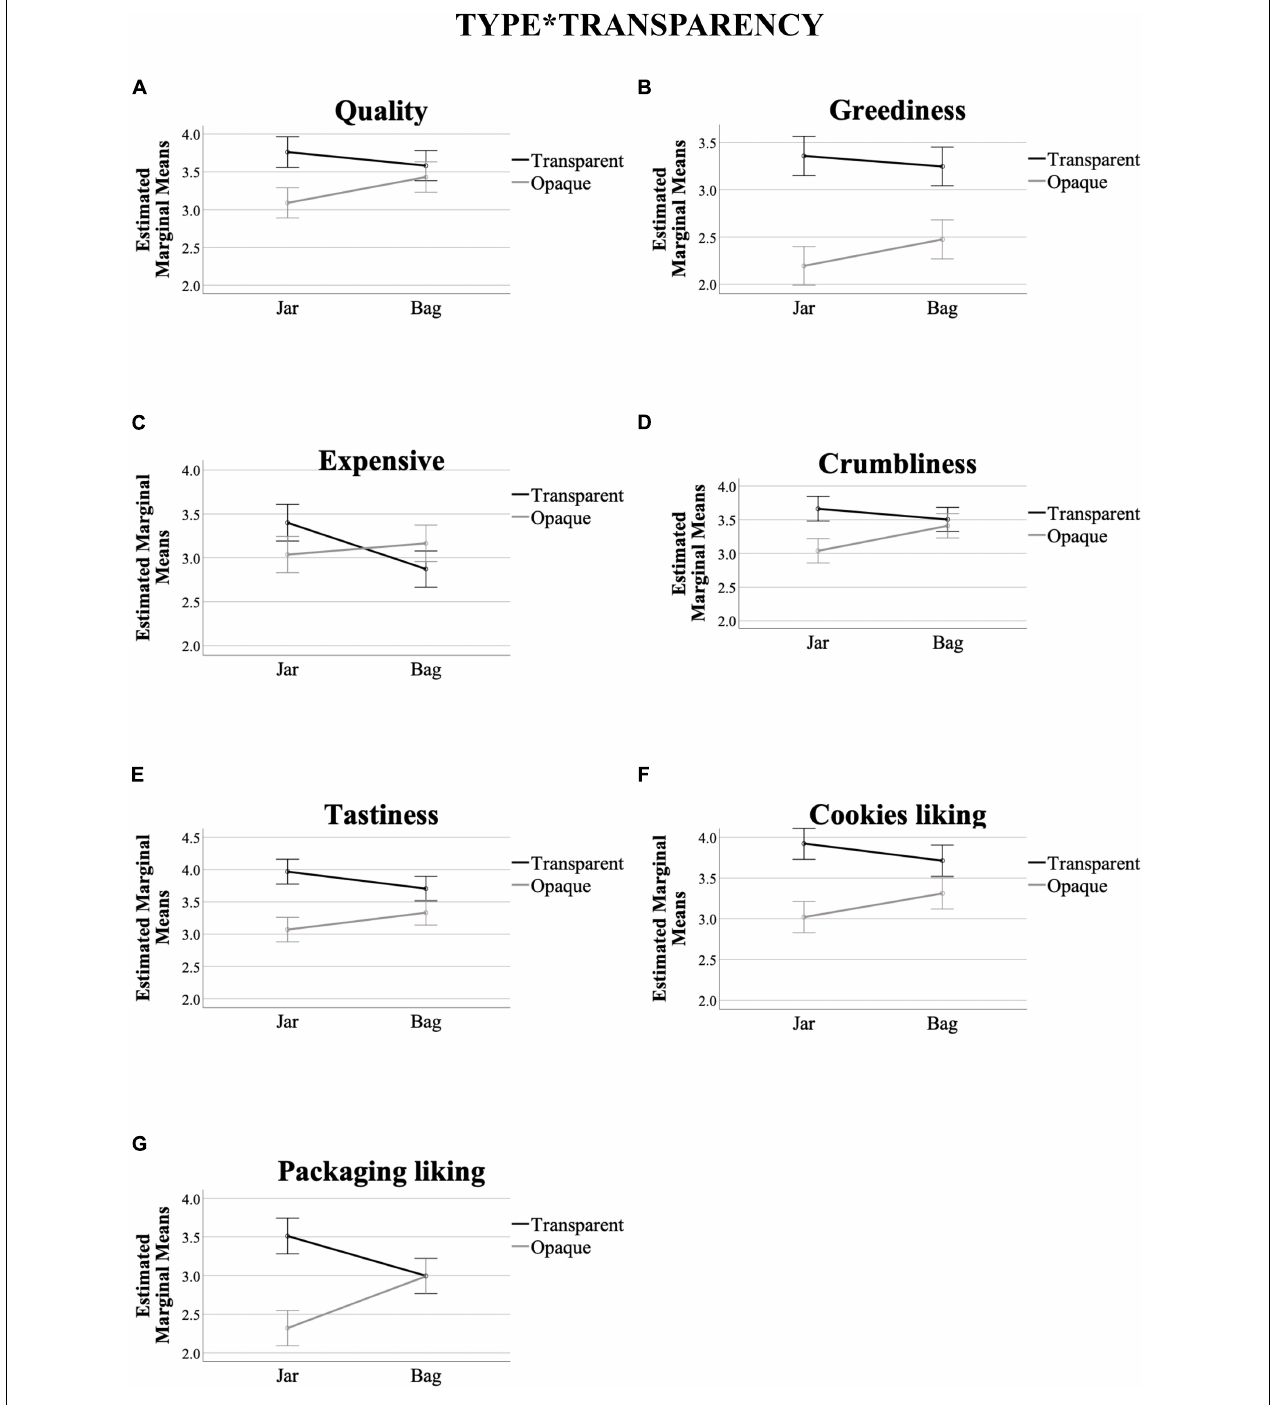
FIGURE 4 | Interaction effects of type*transparency in packaging, across the variables that prompted significant differences at 95% confidence in Table 4 [ (A) Quality, (B) Greediness, (C) Expensive, (D) Crumbliness, (E) Tastiness, (F) Cookies liking, (G) Packaging liking]. Y -axis are the marginal means. X -axis are the type conditions. The black (darker) line corresponds to the transparent packaging values, whereas the gray (clearer) line the opaque ones. Error bars show confidence interval at 95%.